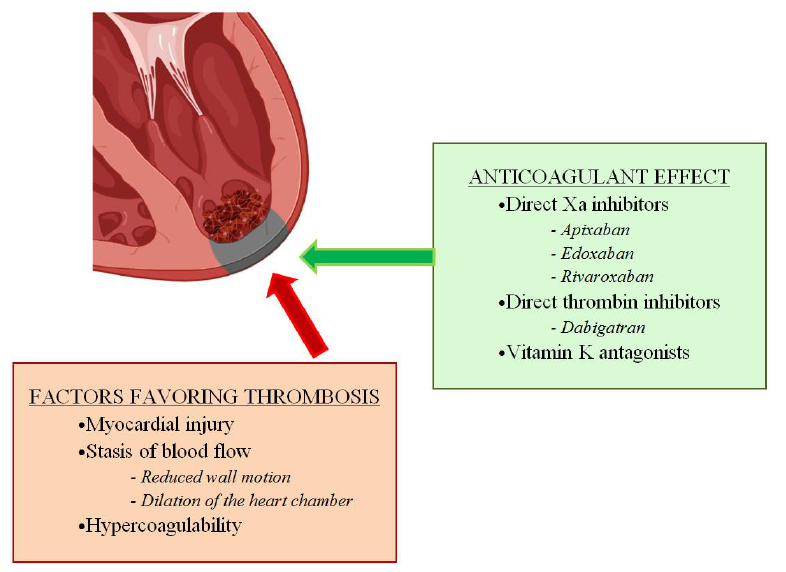
Figure 1. The main determinants of left intraventricular thrombosis and oral anticoagulant treatment options.